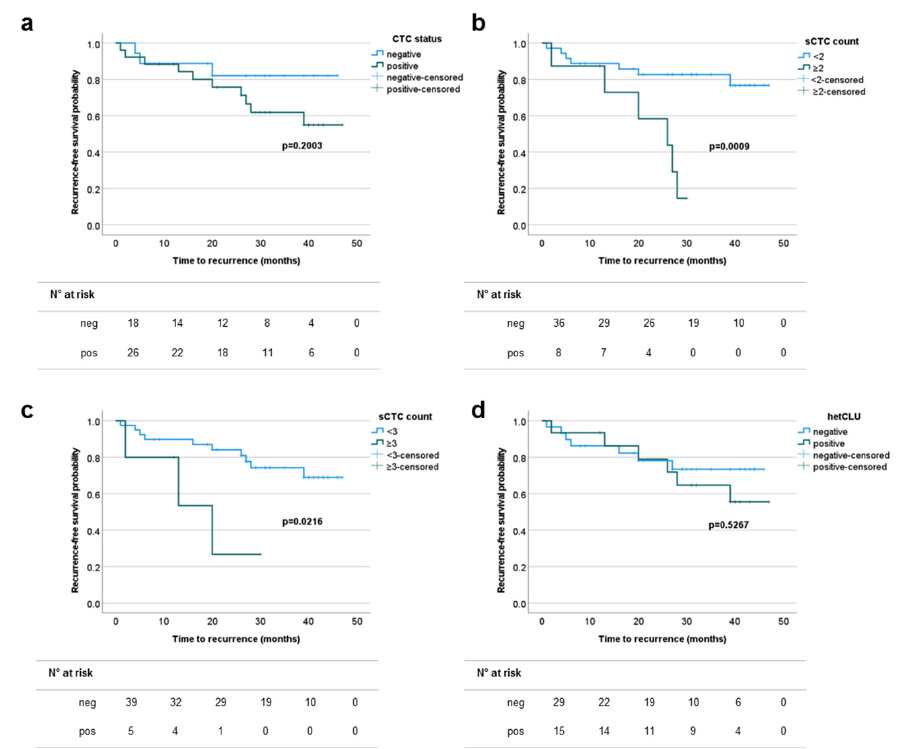
Figure 3. The prevalence of single circulating tumor cells (sCTC) correlates with reduced recurrence- free survival in stages I and II non-small cell lung cancers. Kaplan–Meier plots showing the time-to- event probability of disease recurrence according to ( a ) the presence of CTCs irrespective of the cell subset, ( b , c ) the prevalence of sCTC or ( d ) the presence of heterotypic circulating tumor cell clusters